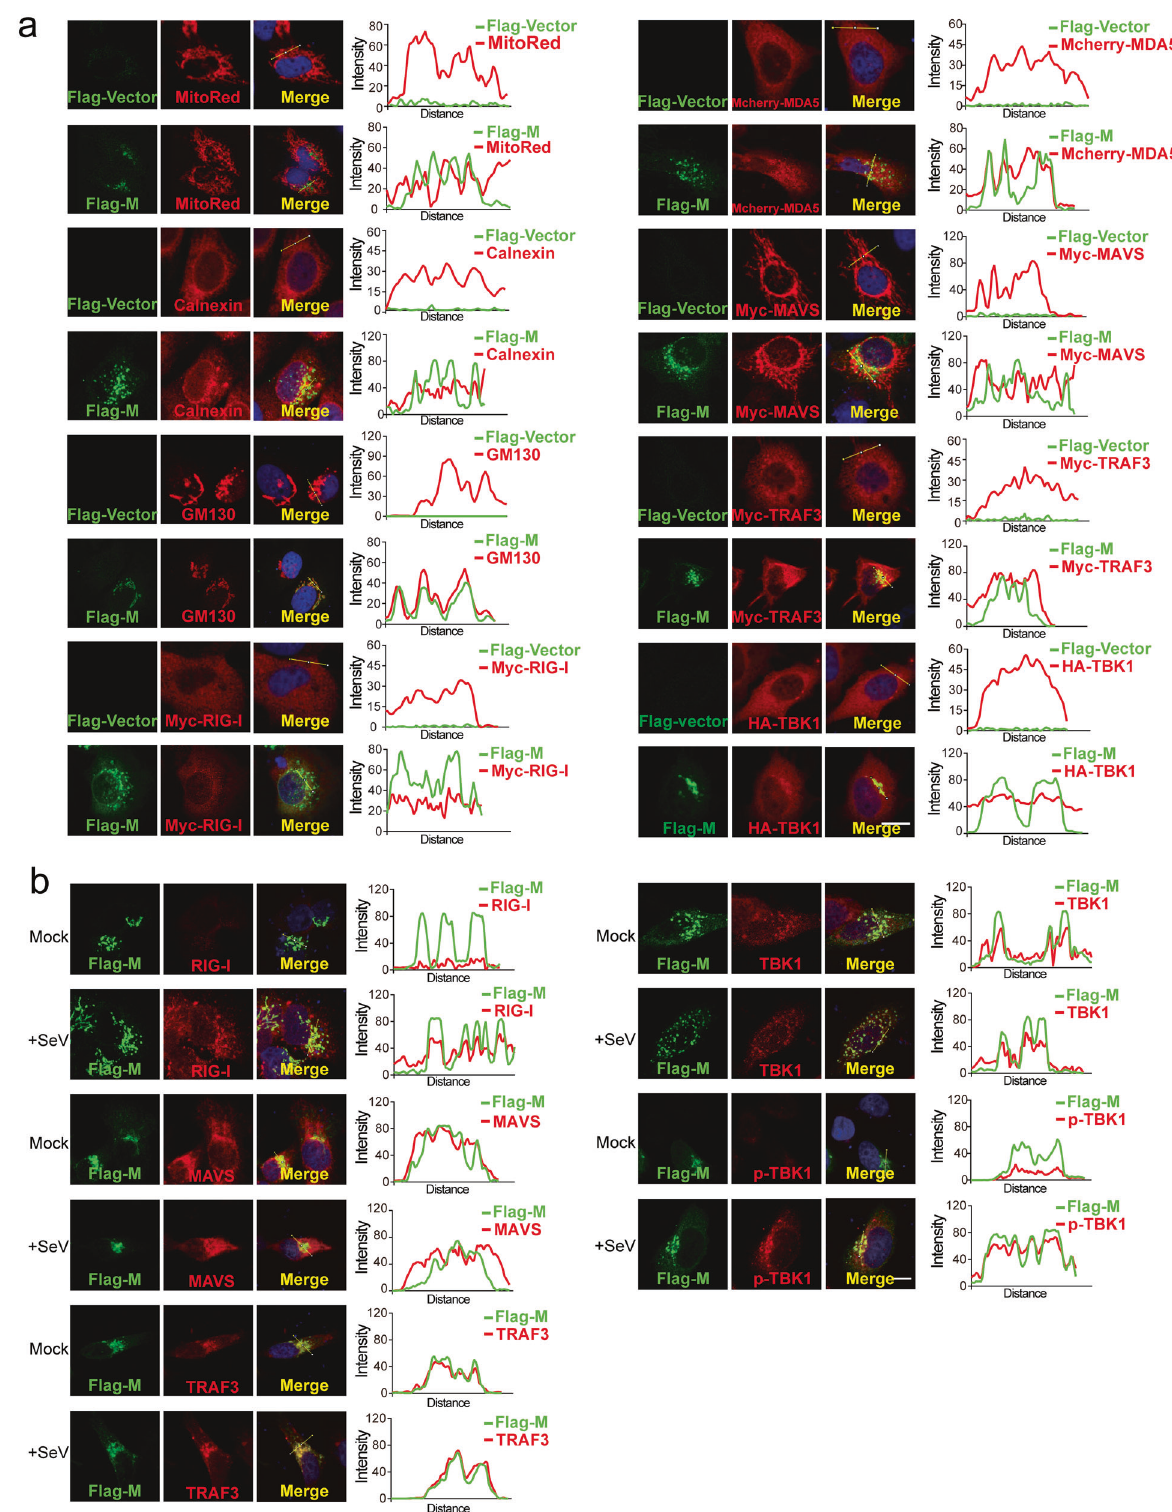
Fig. 3 Subcellular localization of the SARS-CoV-2 M protein. HeLa cells seeded on coverslips in 12-well plates were transfected with the indicated plasmids. Twenty hours later, the cells were fi xed, blocked, and then incubated with a rabbit anti-Flag antibody and a mouse antibody against the corresponding organelle marker or the indicated protein ( a ). HeLa cells in ( b ) were infected with SeV as indicated for 8 h before fi xation, blocking and antibody incubation. Subsequently, the proteins were stained with a fl uorescence-labeled secondary antibody. MDA-5 was visualized with a mCherry tag. (Right) Intensity pro fi les of SARS-CoV-2 M protein (Flag-M) and indicated proteins along the plotted lines, as analyzed by Image J line scan analysis. Nucleus were visualized with DAPI (blue). Confocal imaging results are representative of two independent experiments. Scale bar, 10 μ m. MitoRed, mitochondria marker; Calnexin, ER marker; CM130, Golgi